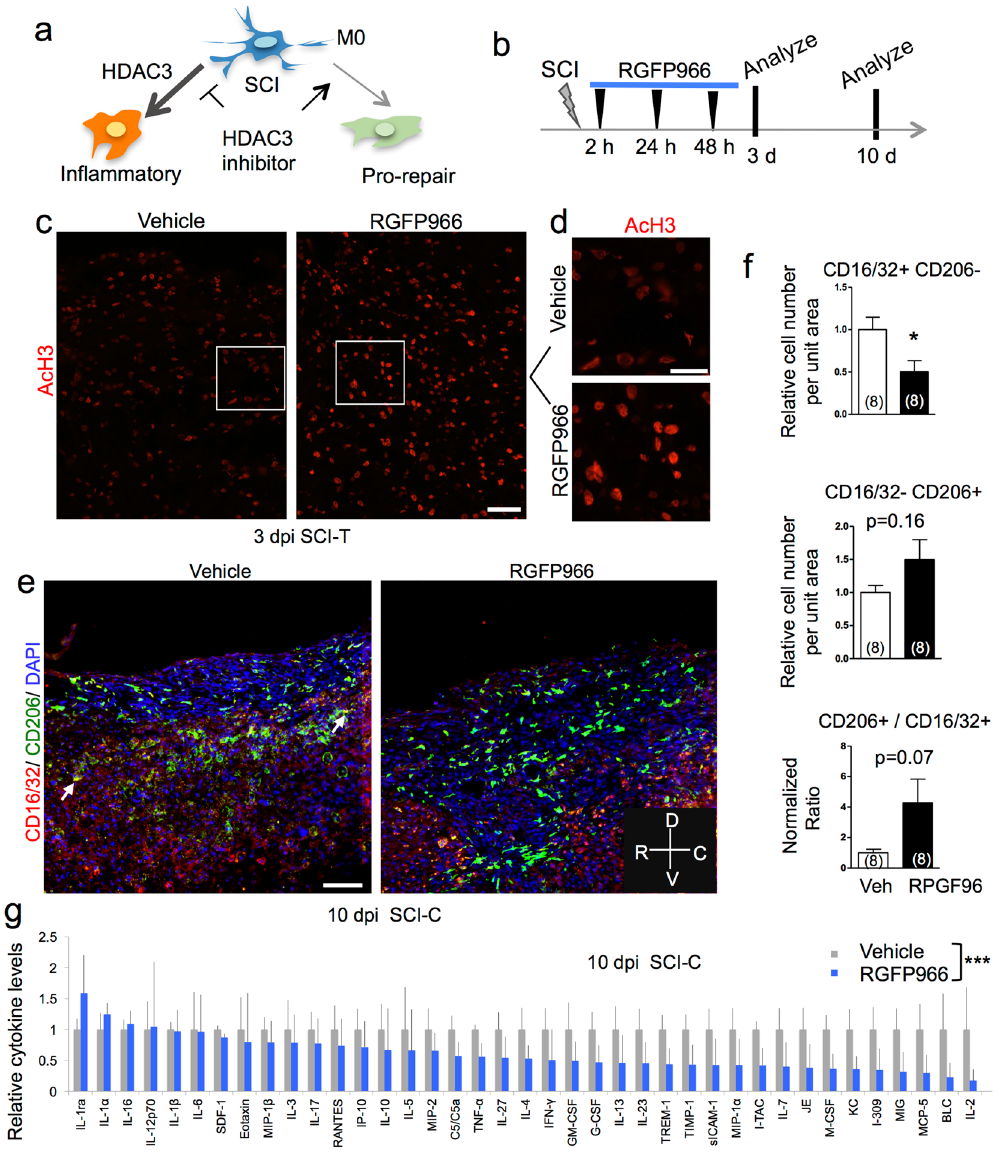
Figure 3. HDAC3 inhibition changes functional state of innate immune cells and leads to global inflammatory suppression in SCI. ( a ) Diagram of divergent macrophage responses and hypothesized role of HDAC3. M0: homeostatic macrophages. ( b ) Experimental scheme of HDAC3 inhibitor treatment after SCI. Three i.p. injections of RGFP966 were delivered. ( c , d ) Representative IHC images showing increased AcH3 levels at the injury site with RPGF966 treatment at 3 dpi after T8 dorsal column transection (SCI-T). Enlarged images in the boxed area are shown in ( d ). ( e , f ) Representative immunofluorescent images and quantification of the numbers of CD16/32 immune cells (green), CD206 immune cells (red), and the ratio of the two subpopulations at the injury site at 10 dpi after contusion injury (SCI-C). DAPI was used for nuclear counterstaining. Arrow: example of double positive cell (CD16/32 + CD206 + ). n = 8 mice per group, with 2–4 representative images averaged for each animal. * p < 0.05, Unpaired Student’s t-test. ( g ) Relative cytokine/chemokine levels as determined by cytokine array using lysates of injured spinal cord from vehicle or RFGP966-treated animals at 10 dpi after contusion SCI. *** p < 0.001, two-way ANOVA with Bonferroni post hoc correction (n = 4 pairs of mice). Orientation: R: Rostral, C: Caudal, D: Dorsal, V: Ventral. Scale bar: 50 µ m ( c ), 25 µ m ( d ), and 100 µ m ( e